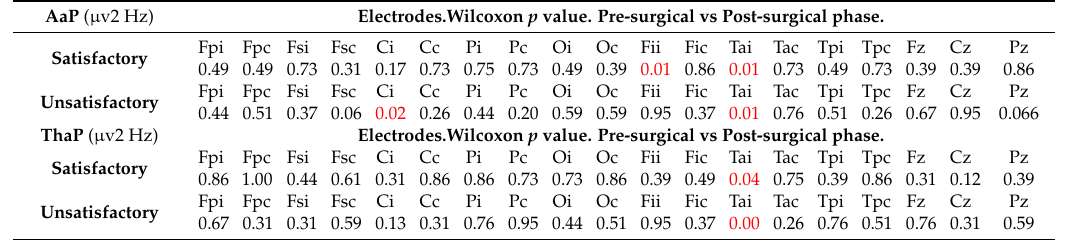
Table A1. Pre-surgical EEG vs. Post-surgical EEG. Patients regroup according to satisfactory and unsatisfactory evolution achieved in the second year. EEG spectral frequency µ v2Hz (Microvolts square per Hertz). Wilcoxon test.Significant p values are shown in